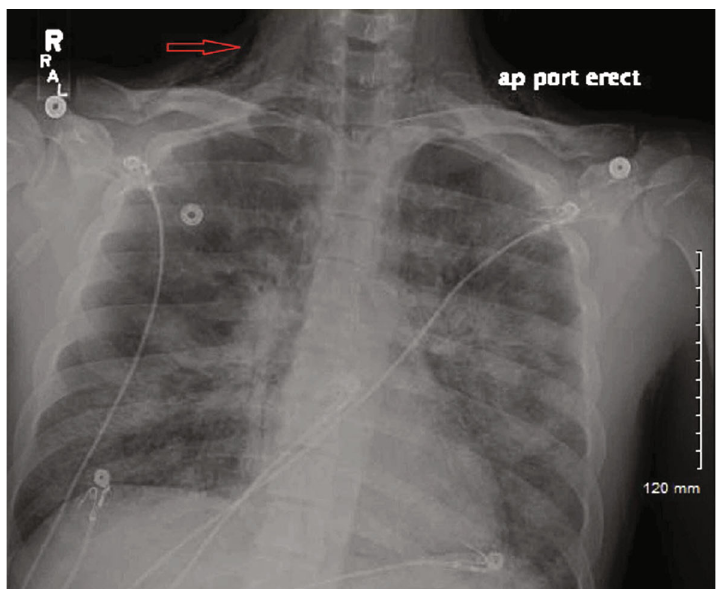
Figure 1: X-ray showing pneumomediastinum with subcutaneous emphysema (red arrow) extending to the cervical region with bilateral pneumonia.